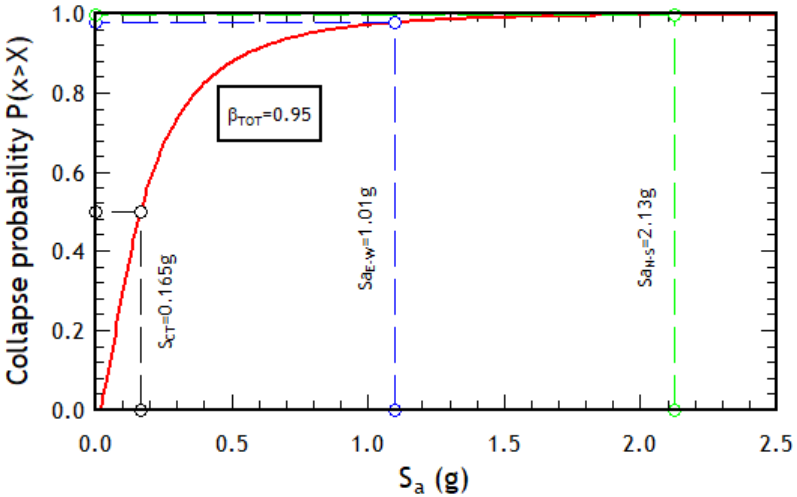
Figure 14. Collapse fragility curve obtained from the IDA analysis of the analyzed building.